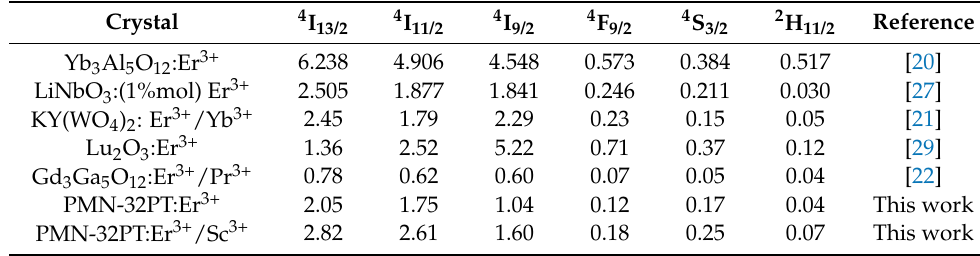
Table 6. Radiative lifetimes of Er 3+ in laser